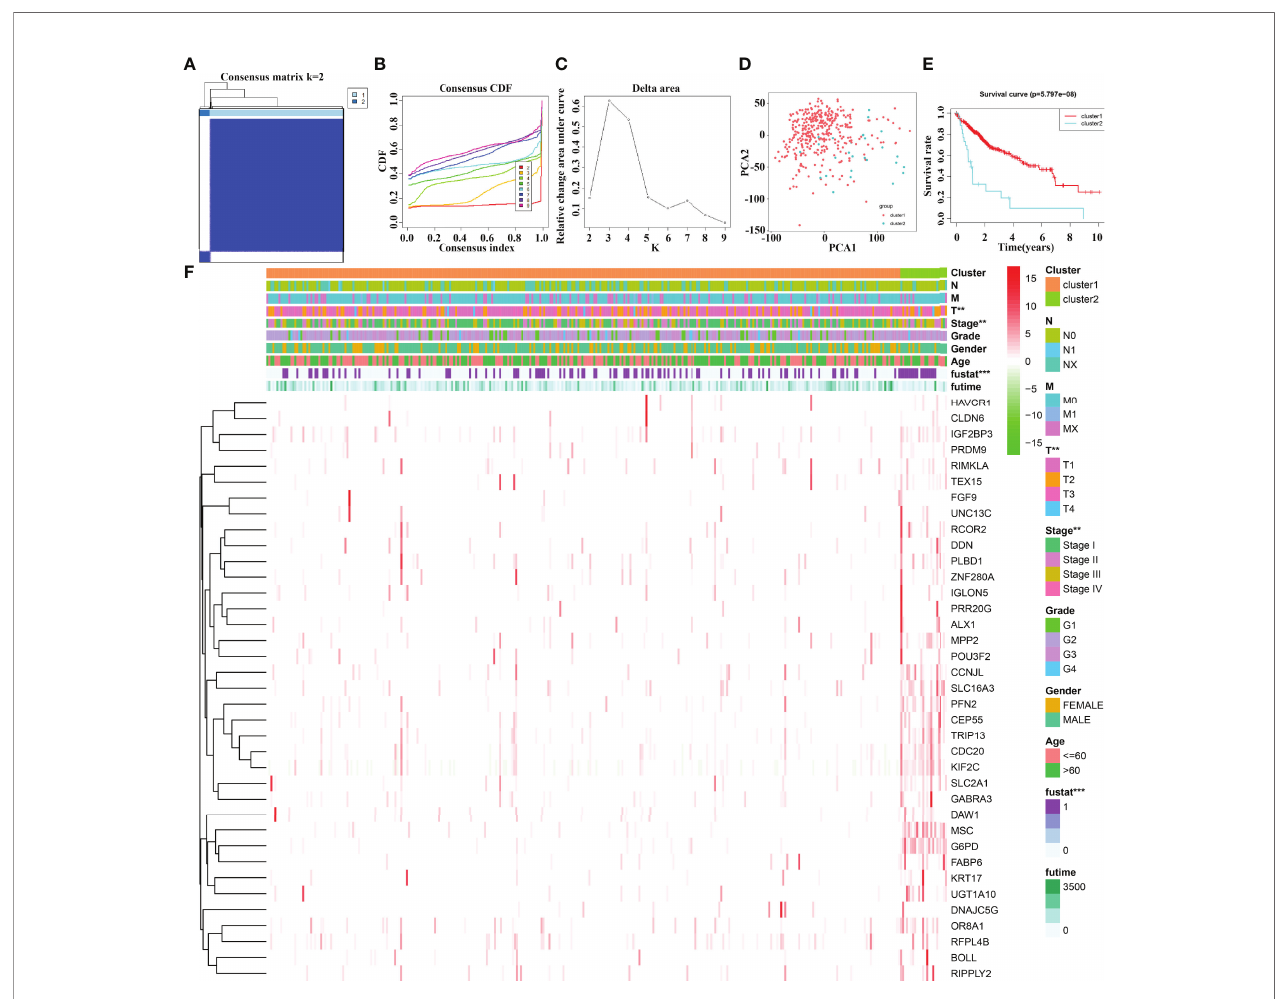
FIGURE 4 | The prognostic value of 37 cluster-related DEG subgroups in HCC based on consensus clustering. (A – C) The consensus clustering of 37 cluster- related DEGs. (D) PCA. (E) K-M survival analysis. (F) The relationships between the clinicopathological features and 37 cluster-related DEG subgroups. HCC, hepatocellular carcinoma; PCA, principal component analysis; K-M, Kaplan – Meier; differentially expressed genes; **P < 0.01; ***P <